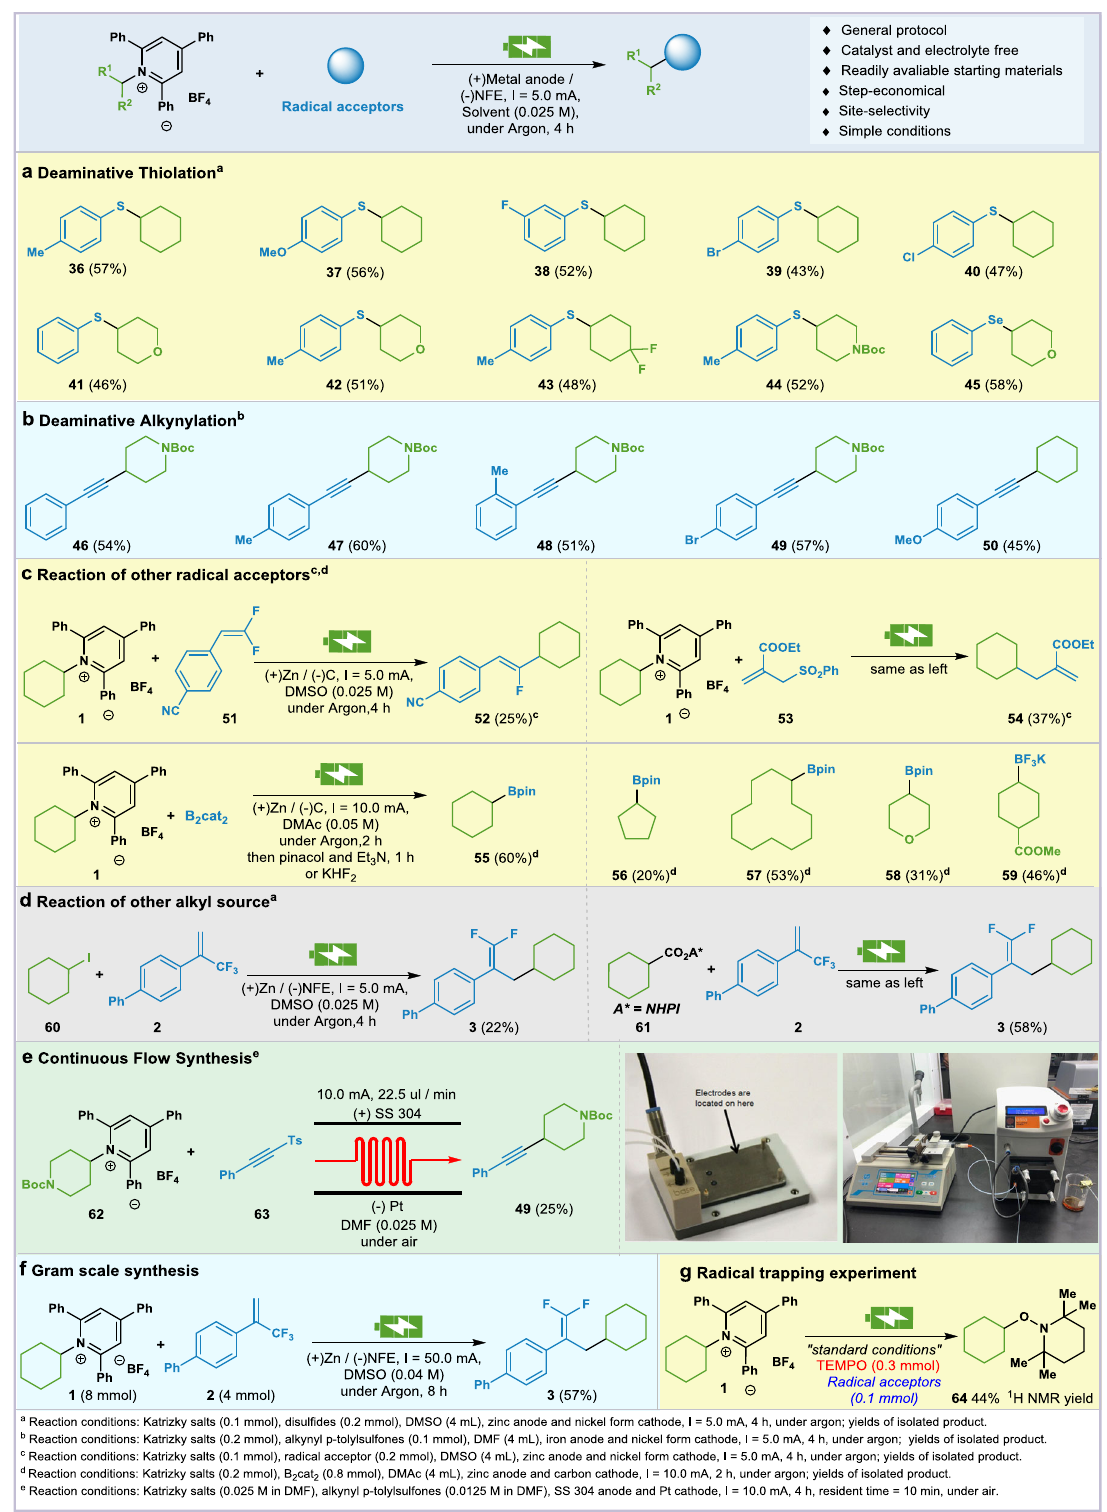
Fig. 4 Scope of other radical acceptors and further elaboration. a Deaminative thiolation. b Deaminative alkynylation. c Other radical acceptors. d Other alkyl source. e Micro fl uid synthesis. f Gram scale synthesis. g Radical trapping experiment. General procedure for the electrochemical reductive cross-coupling between foamed nickel electrode (52.5 × 8× 2mm) as the cathode. The reaction mixture alkylpyridinium salts and tri fl uoromethyl alkenes . An oven-dried undivided was stirred and electrolyzed at a constant current of 5mA (The dual display potentiostat was operating in constant current mode) under room temperature for reactor (10 mL) equipped with tri fl uoromethyl alkenes (0.1 mmol), alkylpyr- 4 h. When the reaction was completed, the solution was extract by ethyl acetate idinium salts (0.2mmol) and a stir bar before adding DMSO (4mL). The (3 × 15mL), and the combined organic layers were concentrated with a rotary reactor was equipped with zinc electrode (52.5 ×8 ×2 mm) as the anode and NATURE COMMUNICATIONS| (2021) 12:6745